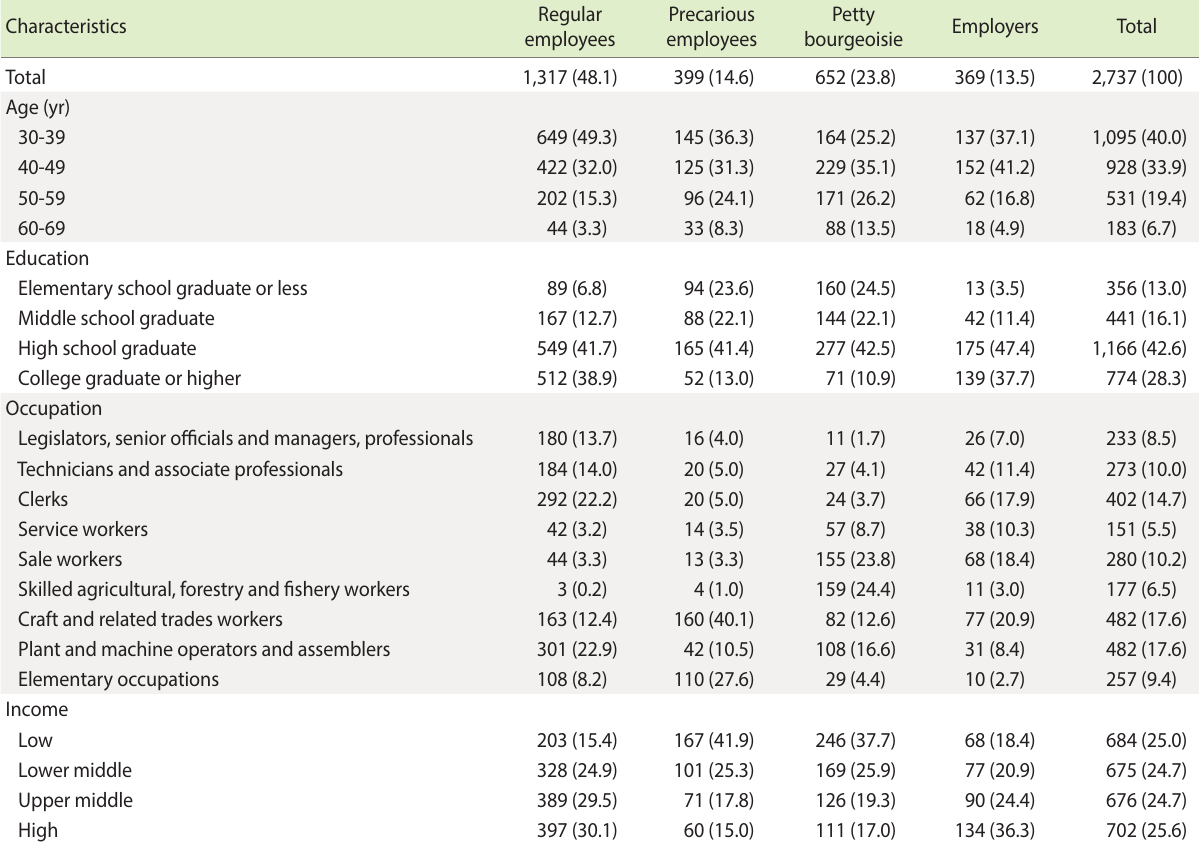
Table 1. Characteristics of study subjects by employment status among employed men aged 30-69 years in 1999